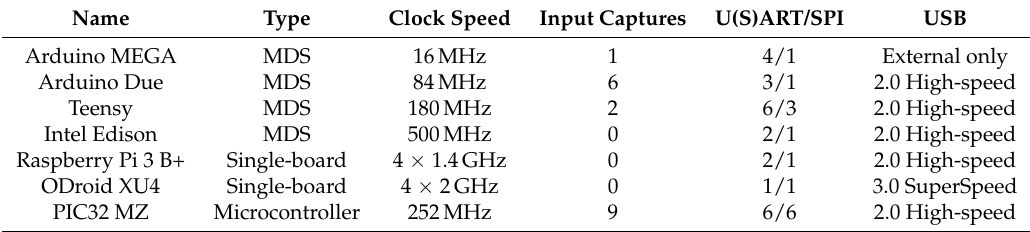
Table 1. Comparison of hardware capabilities of embedded